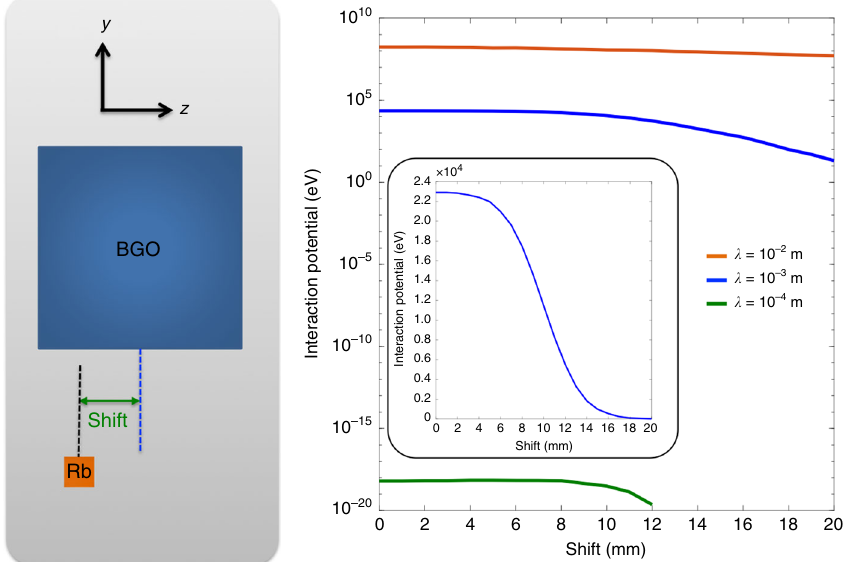
Fig. 2 The interaction potential calculation. The interaction potential P eff , numerically calculated by a Monte Carlo integration, as a function of the distance between the center of the bismuth germanate insulator (BGO) mass and the center of the rubidium (Rb) vapor cell, Shift, at different interaction ranges of λ = 10 − 4 , 10 − 3 , and 10 − 2 m. The vertical axis has a log scale. When the Shift = 0, the centers of the BGO mass and the Rb vapor cell are aligned. The inset enlarges the interaction potential at λ = 10 − 3 m with the vertical axis in a linear